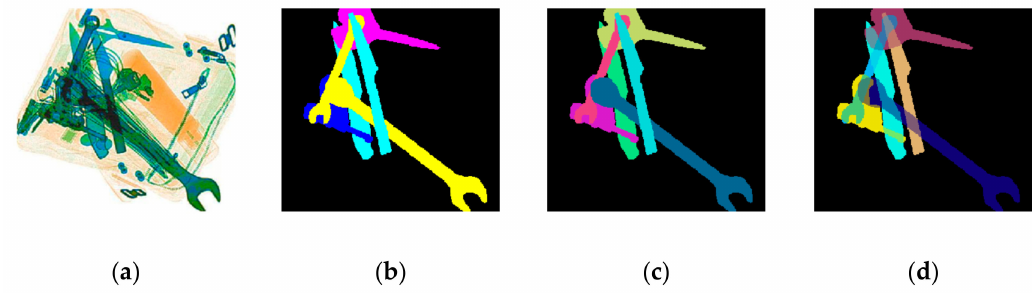
Figure 3. Pixel-level annotations for different tasks. ( a ) Input image with overlapping objects. ( b ) Semantic segmentation ground truth labels. ( c ) Instance segmentation ground truth labels. ( d ) Object separation ground truth labels.